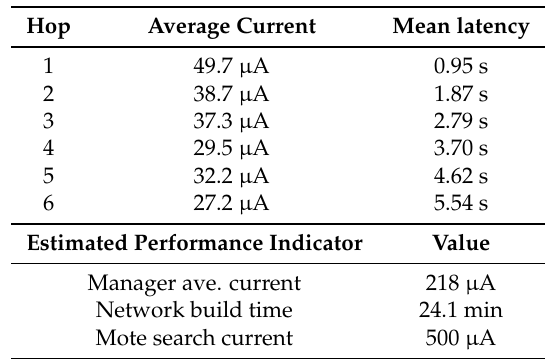
Table 5. Performance Estimator